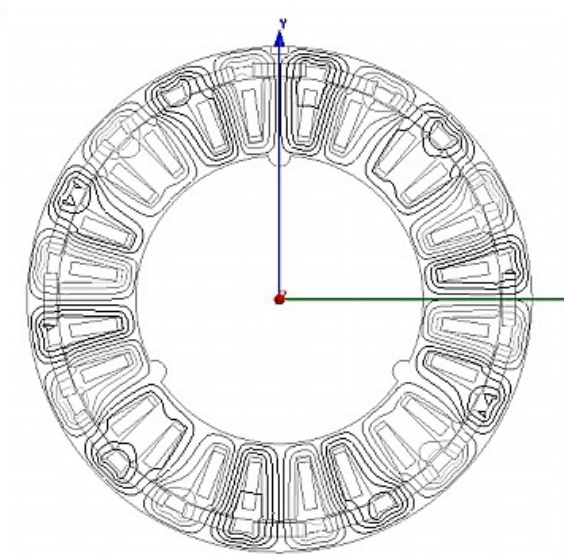
Figure 7. Magnetic flux lines of unequal teeth stator with rectangular shaped stator poles.